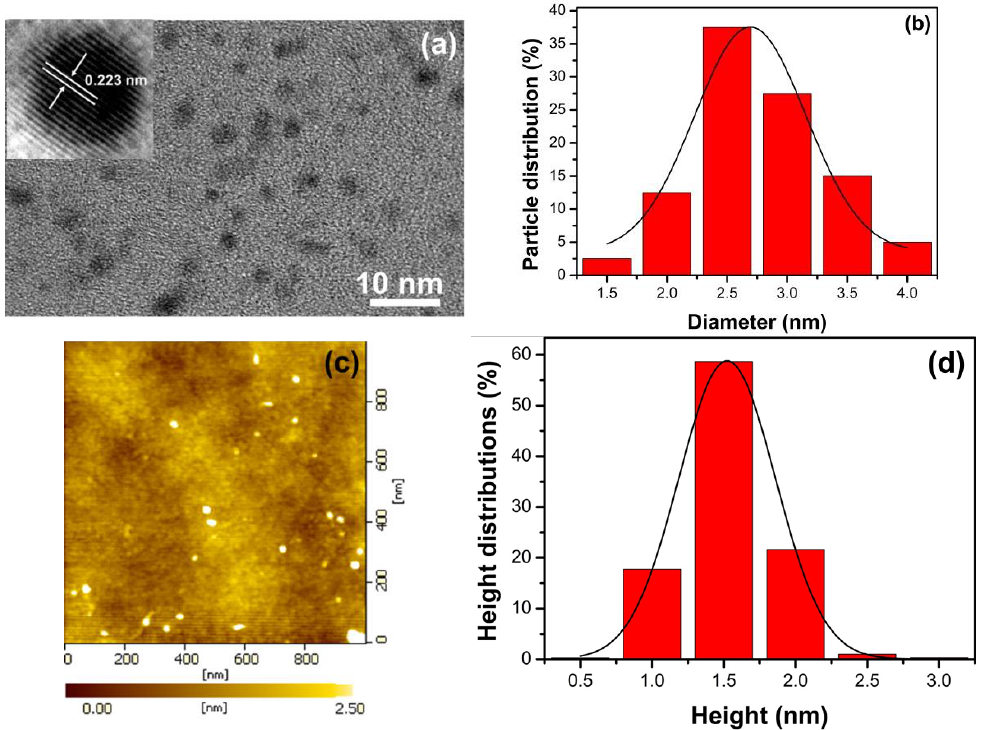
Figure 4. ( a ) TEM image of N, S-GQDs and HRTEM image are inserted as insets; ( b ) the corresponding particle size distribution (n = 40); ( c , d ) atomic force microscope (AFM) image and particle height distribution of as-synthesized N, S-GQDs.